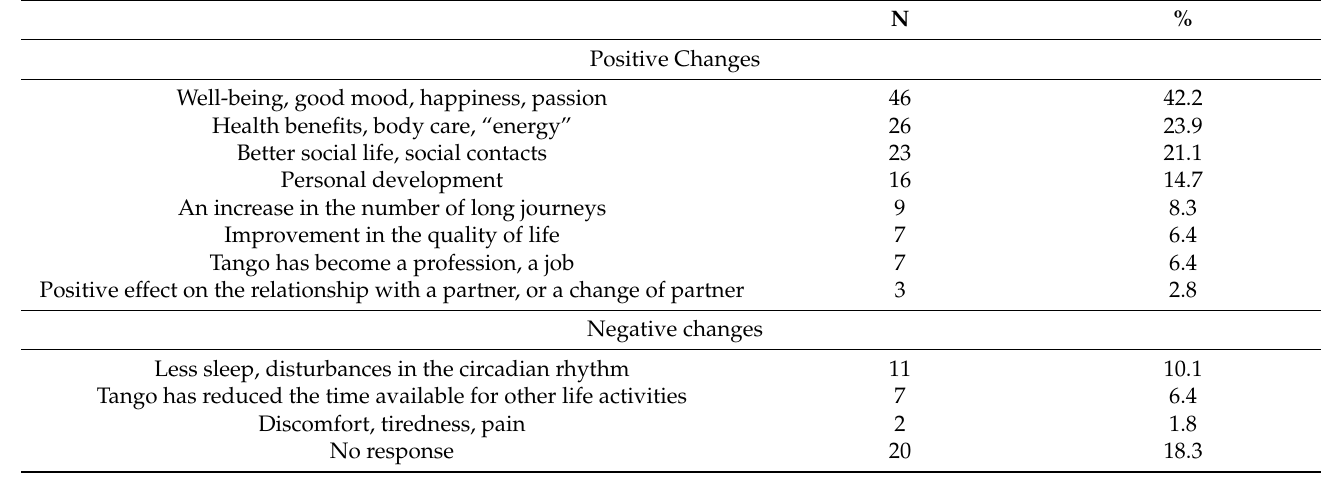
Table 6. Positive and negative changes in the personal lives of dancers caused by engaging in the physical activity of AT dancing; N—number of female dancers, %—percentage of female